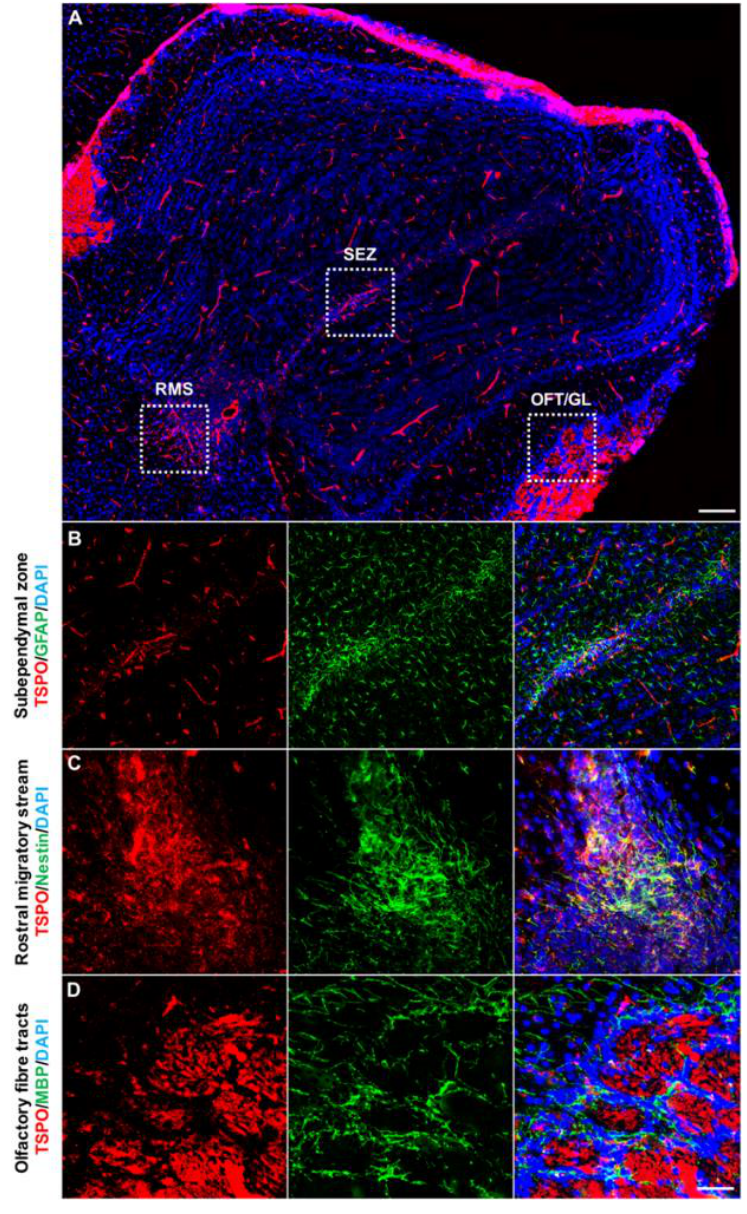
Figure 3. TSPO expression across the olfactory bulb in the normal mouse brain. ( A ) Sagittal view of TSPO expression (red) across the olfactory bulb. Structural features of the region highlighted with DAPI (blue). ( B ) Concentrated TSPO expression (red) is observed in the subependymal zone, which houses a neural stem cell niche derived from the rostral migratory stream (RMS). TSPO colocalizes at low levels with GFAP+ (green) cells. ( C ) TSPO is present at the base of the RMS, entering into the olfactory bulb. Here, TSPO strongly colocalizes with Nestin+ (green) cells. ( D ) TSPO expression (red) is also observed in the olfactory nerve layer and glomerular layer, though does not colocalize with MBP+ oligodendrocytes (green) of the region. Scale bars = 300 µm for ( A ), 20 µm for ( B – D ). RMS = rostral migratory stream, SEZ = subependymal zone, OFT = olfactory fibre tracts, GL = glomerular layer.